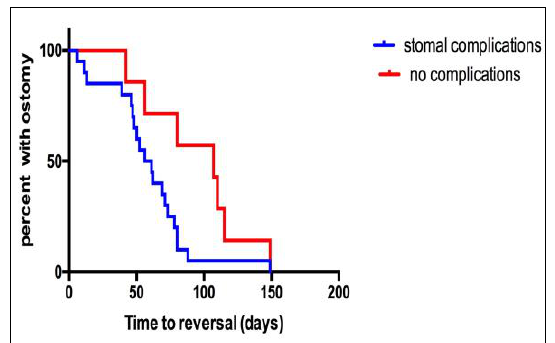
Figure 1: Kaplan-Meier curve of number of patients with ileos- tomy. In complication group an early reversal is evident. Table 1: Stomal complications and type of ileostomy Stoma related